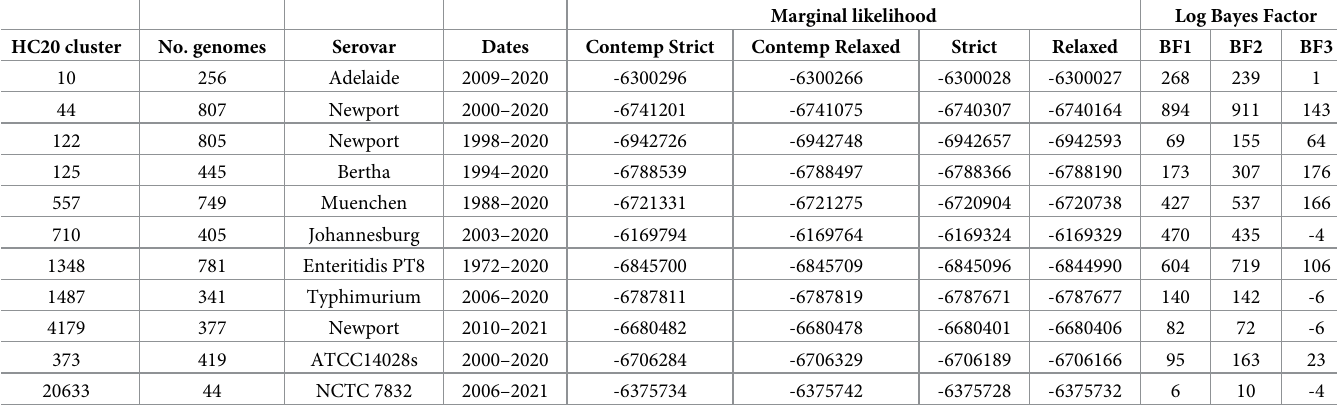
Table 4. Statistically significant temporal signals within non-repetitive core genome SNPs in HC20_373 and other HC20 clusters. Marginal likelihood Log Bayes Factor